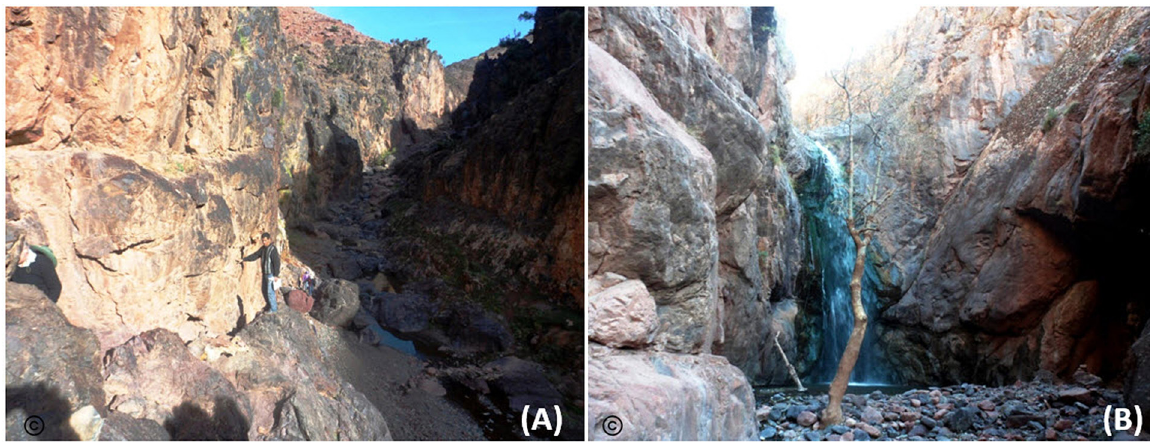
Fig. 10. Canyon of Megdaz, B) Asfdar